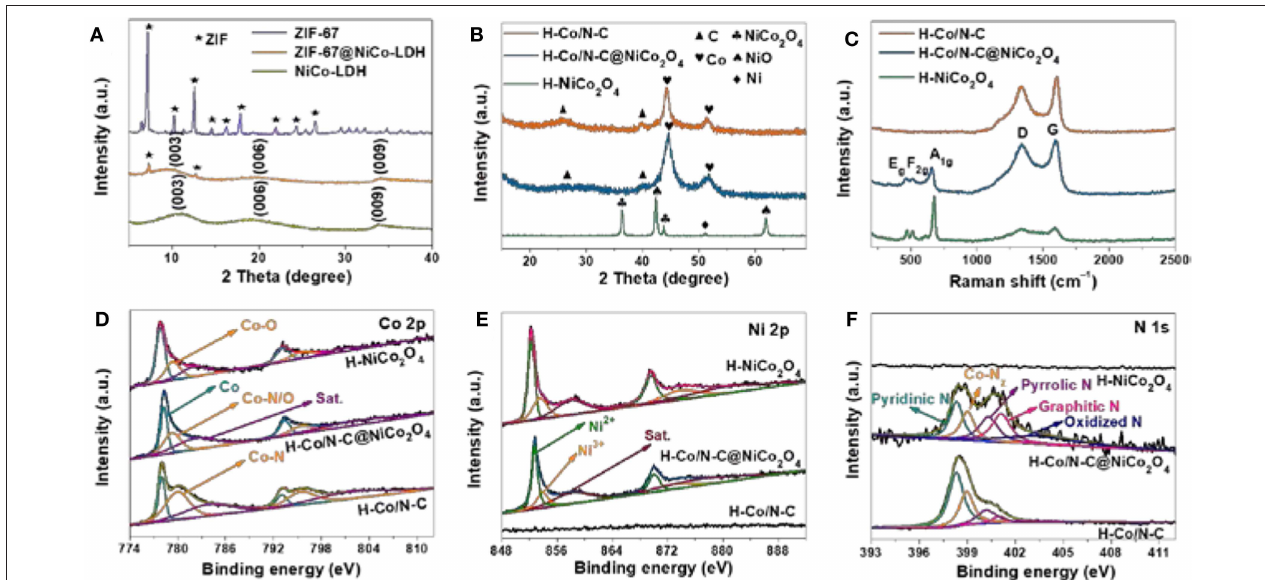
( Figure 1g and Figure S5 ). During the etching process,